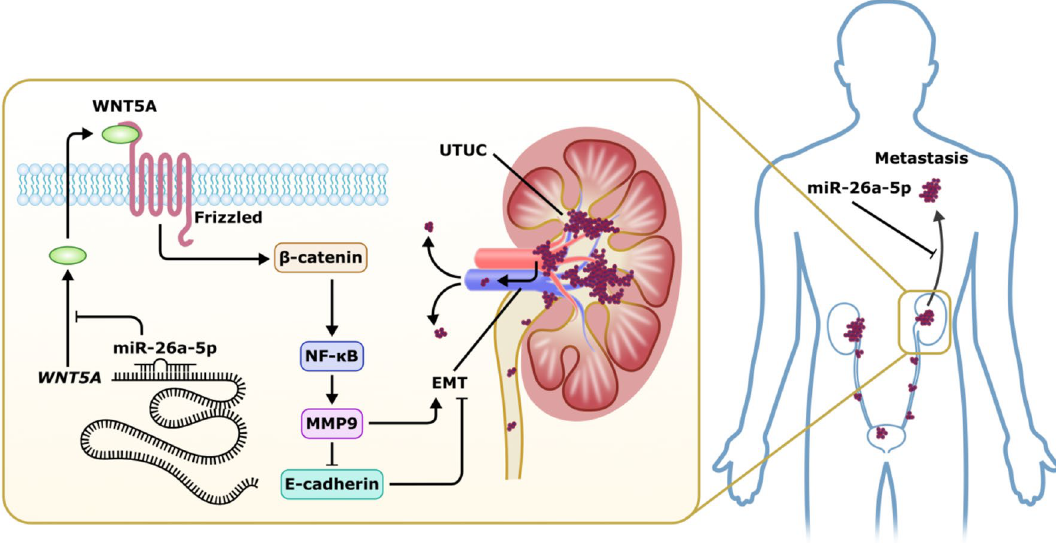
Figure 7. Proposed mechanism for the effects of miR-26a-5p on WNT5A/β-catenin signaling in tumorigenesis of upper tract urothelial carcinoma (UTUC). Our findings revealed that miR-26a-5p gene delivery may induce simultaneous suppression of WNT5A and β-catenin expression and their downstream NF-κB and MMP-9 proteins. The suppression of WNT5A/β-catenin signaling axis by miR-26a-5p restoration could reverse the processes of epithelial-to-mesenchymal transition (EMT) of UTUC cells, including E-cadherin disruption, thereby suppressing their metastasis